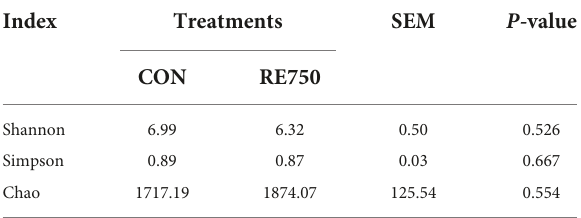
TABLE 7 The α diversity index of gut microbiota in broilers of CON and RE750 1